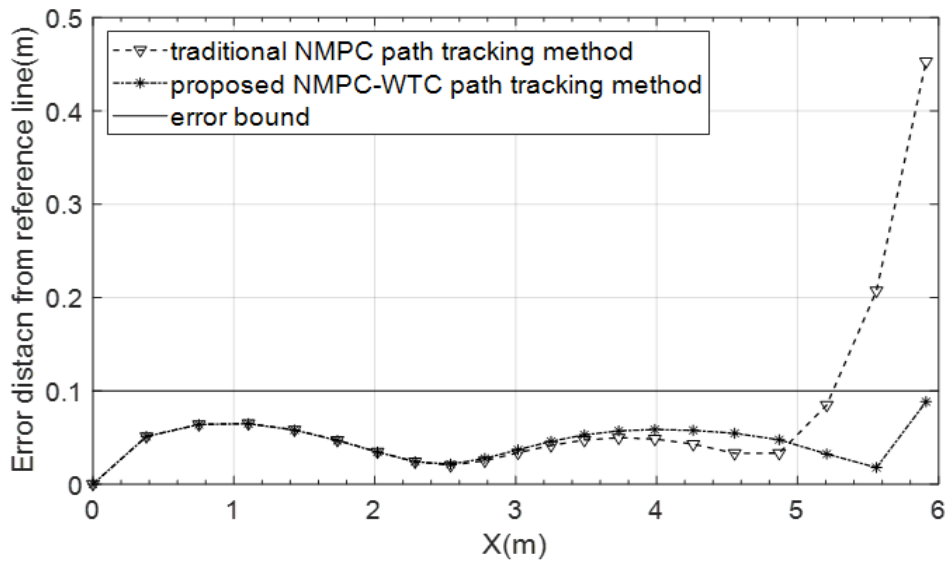
Figure 4. Schematic diagram of open-loop prediction error of vehicle lane change.